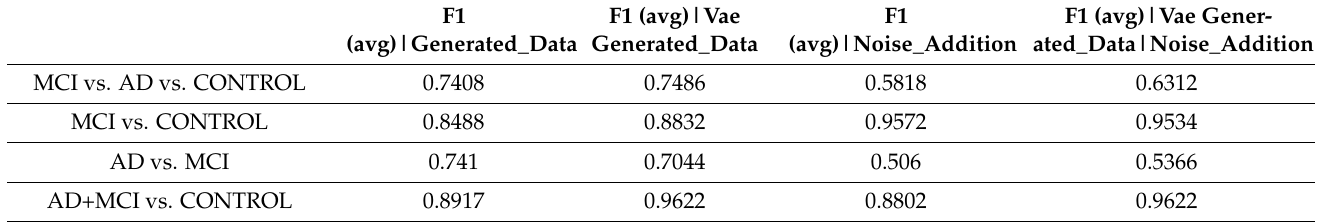
Table 6. Average accuracy and F1Score criteria for 50 trials for different time intervals. Results for 15 s (accuracy).